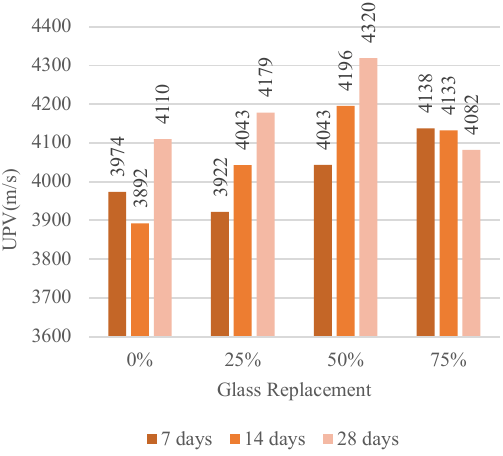
Figure 9. UPV Results at 7, 14, and 28 Days.